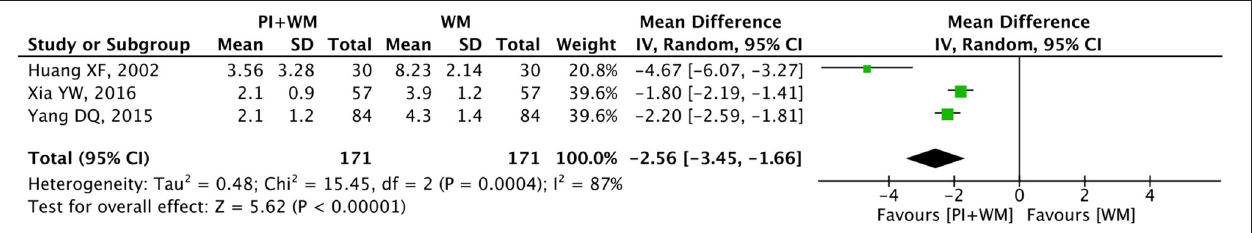
FIGURE 7 | Funnel plot on the duration of angina attack.